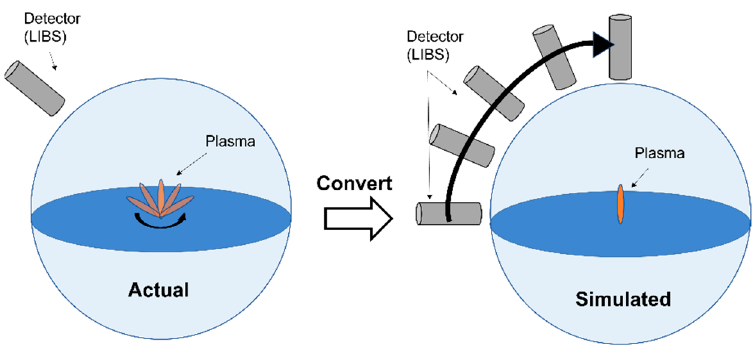
Figure 9. Schematic diagram of the relationship between plasma deformation and detector position in simulation.